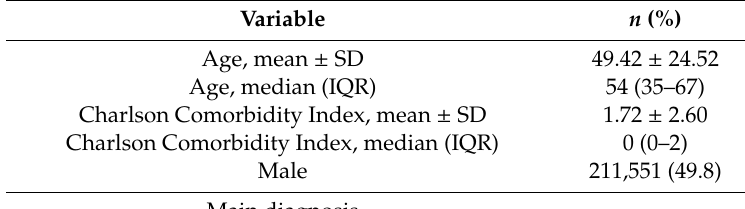
Table 1. Demographics of the study population ( n =